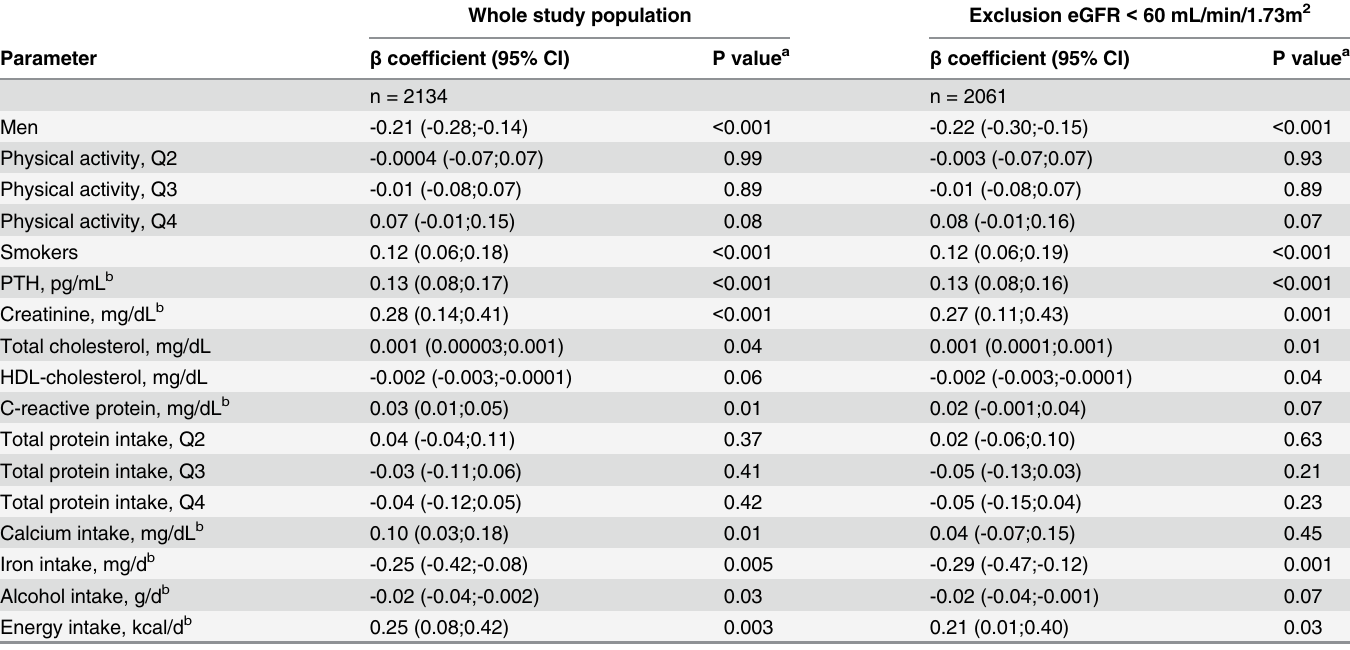
Table 3. Multivariable linear regression for the associations between FGF23 concentrations and the best subset of FGF23 correlates, mutually adjusted for each other.